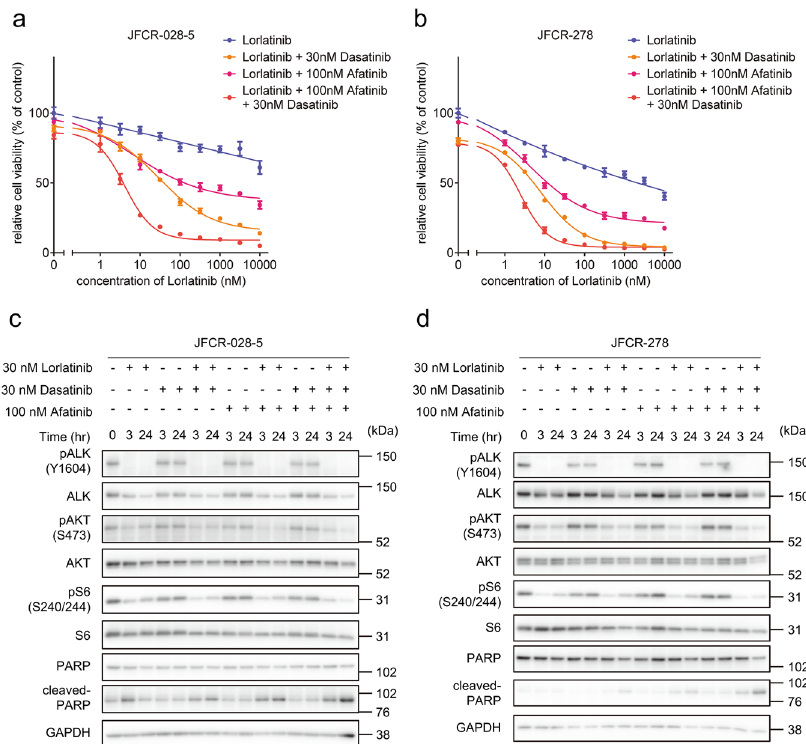
Fig. 7 Combination therapy of lorlatinib, Src family kinase inhibitor, and EGFR inhibitor showed signi fi cant suppression of cell viability in lorlatinib-acquired resistance cells. Cell viability of a JFCR-028-5 and b JFCR-278 cells treated with the indicated concentration of lorlatinib with or without a fi xed concentration of dasatinib or afatinib for 72 h ( n = 3). Each point represents the mean ± SD of three replicates. Western blot analysis showing suppression of phospho-ALK and its downstream signaling in c JFCR-028-5 and d JFCR-278 cells treated with 30 nM lorlatinib in the absence or presence of the indicated concentration of dasatinib or afatinib for 0, 3, and 24 h. GAPDH was used as a loading